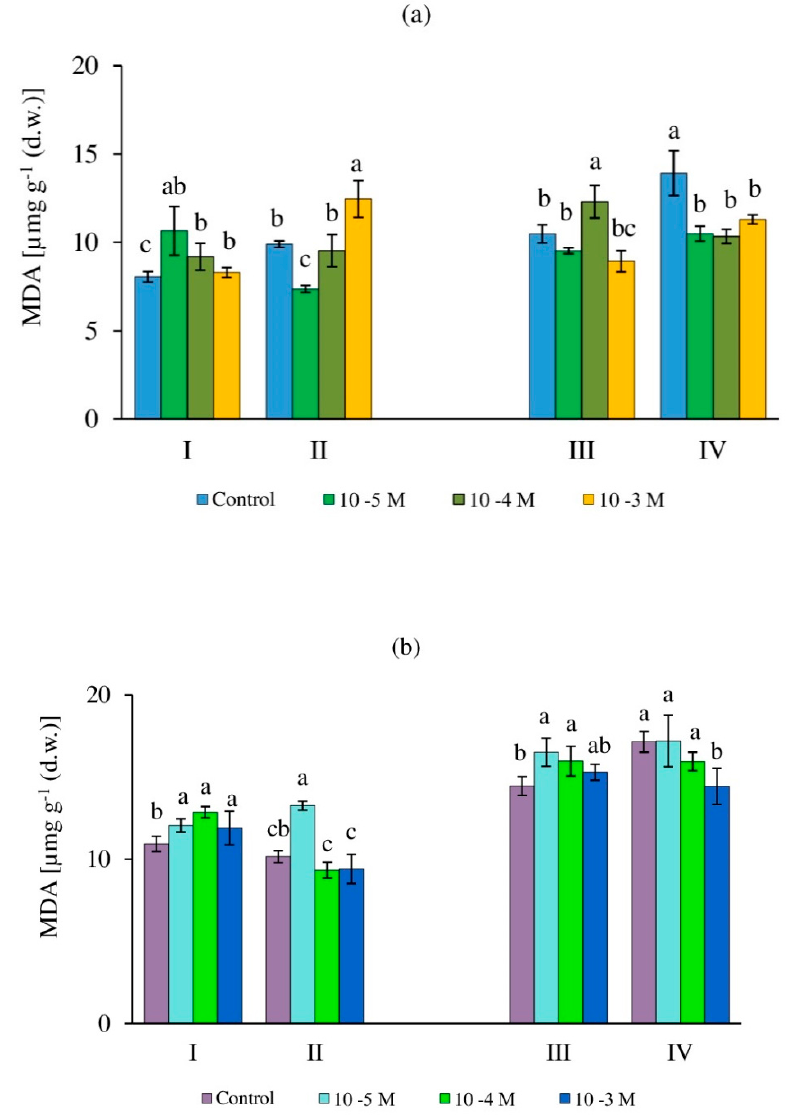
Figure 3. Content of malondialdehyde (MDA) in callus cultures of tea plants 24 days old (I, II) and 36 days old (III, IV) grown in the dark ( a ) or in the light ( b ) and exposed to various concentrations of H 2 O 2 —0 (control), 0.01 mM, 0.1 mM, and 1 mM. Variants: I, III—rapid response of callus cells (2 h exposure to H 2 O 2 ); II, IV—delayed response of callus cells (48 h after exposure to H 2 O 2 ). Different letters indicate significant differences between exposure conditions ( p ≤ 0.05).